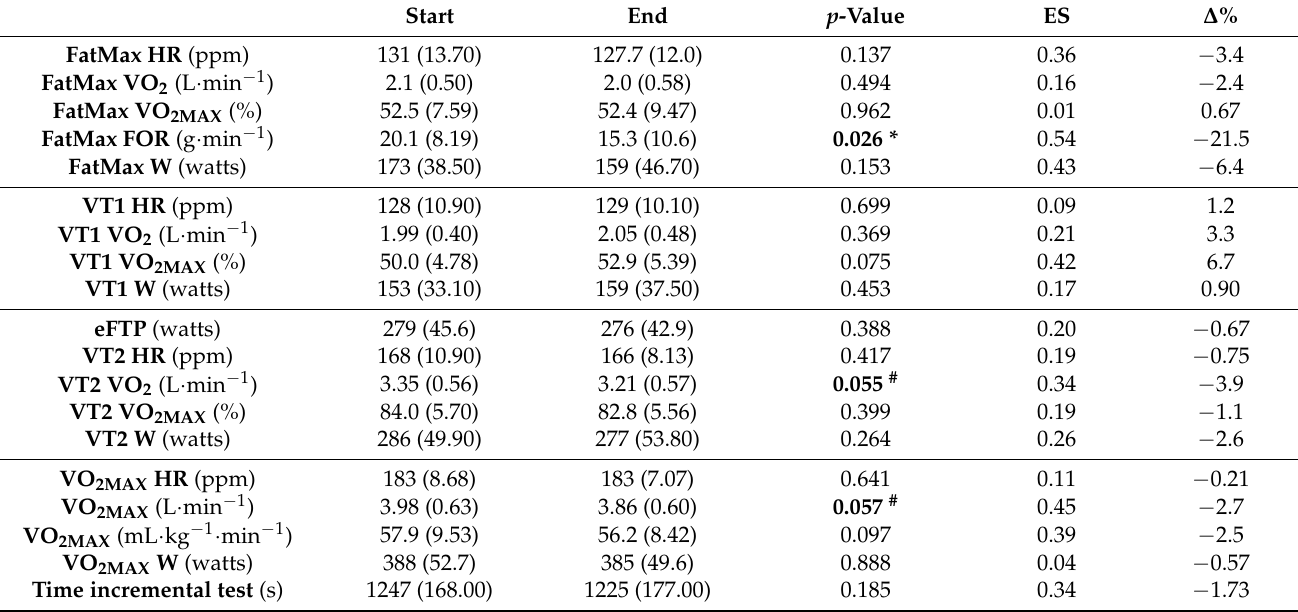
Table 6. Changes in metabolic and performance markers during the off-season in well-trained cyclists. Start End p -Value ES ∆ % FatMax HR (ppm) 131 (13.70)